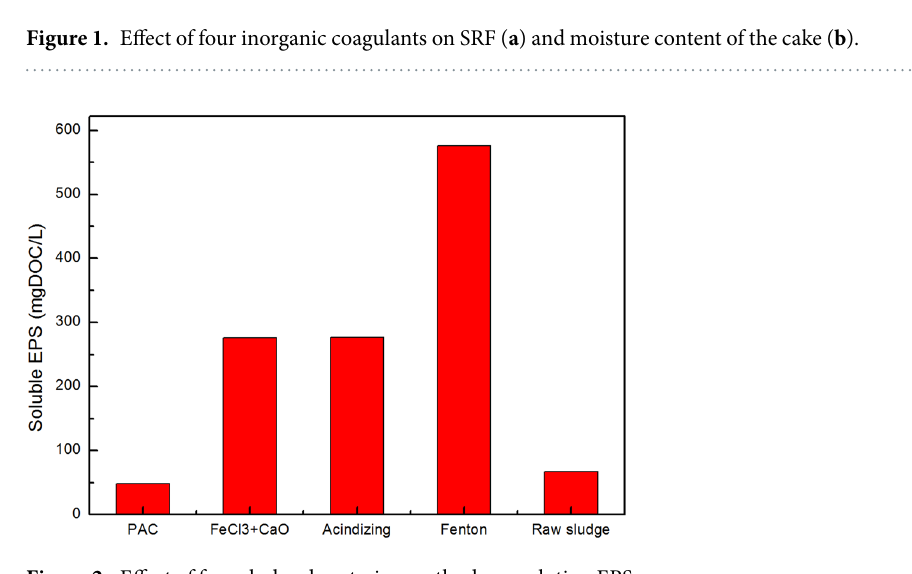
Figure 2. Effect of four sludge dewatering methods on solution